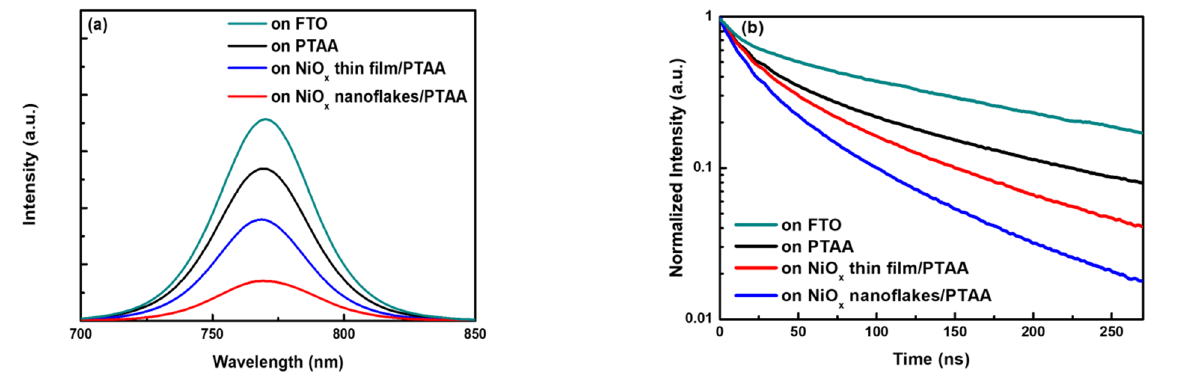
Figure 9. ( a ) PL emission spectra and ( b ) TR-PL decay curves of the perovskite on the FTO glass substrate, PTAA, NiO x thin film/PTAA, and NiO x nanoflakes/PTAA.